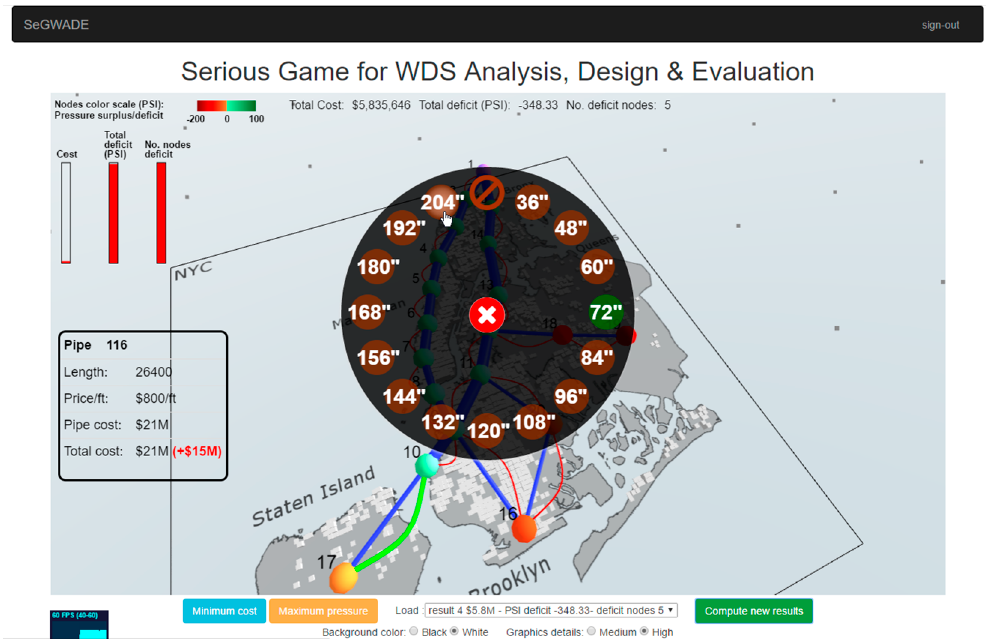
Figure 2. The SeGWADE 3D interface showing a diameter selection wheel with the associate information box for a selected pipe (highlighted in green).